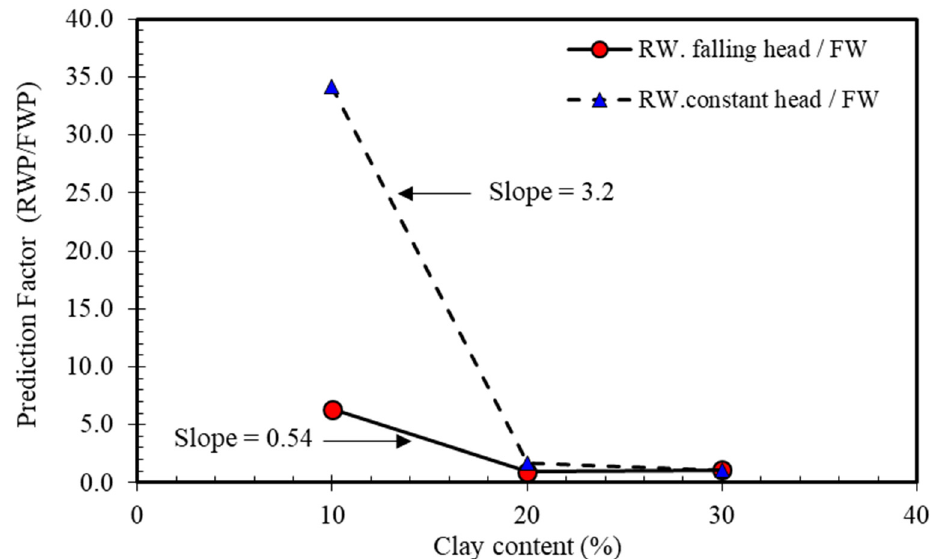
Figure 10. Hydraulic conductivity prediction factor for a rigid wall/flexible wall measurement at variable clay content.